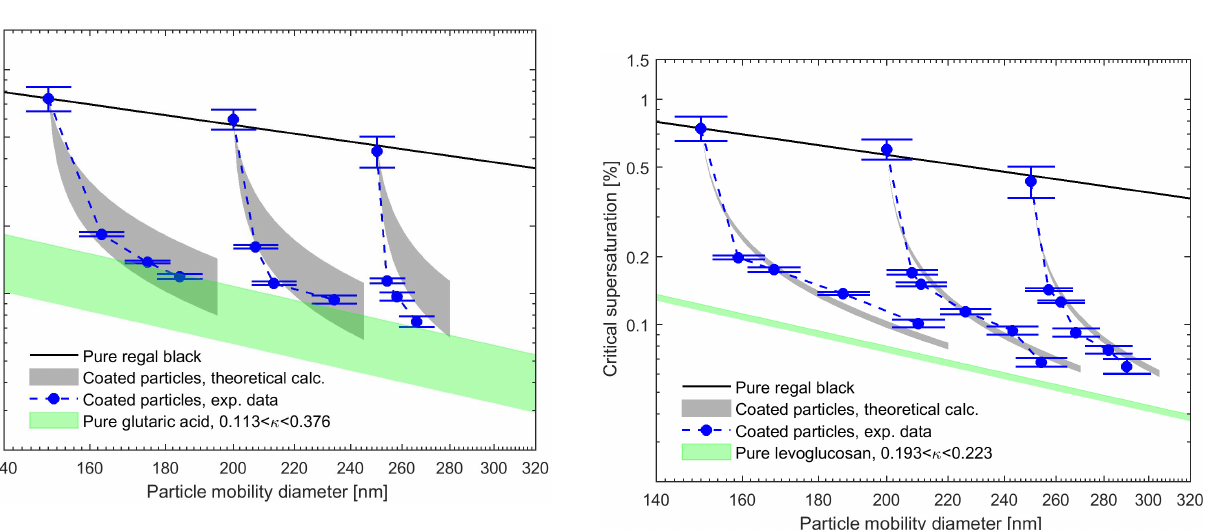
Figure 5. Experimental and theoretical critical supersaturations for BC particles coated by glutaric acid for different particle mobility diameters. The black line represents the calculated critical super- saturations of the pure BC particles using the FHH adsorption ac- tivation theory (Eq. 10). The gray shaded areas define the critical supersaturations calculated using Eq. (9) and variety of the κ val- ues reported in the literature for glutaric acid (see Table 1). The green shaded area represents the critical supersaturations from the κ -Köhler theory (Petters and Kreidenweis, 2007) for the pure glu- taric acid particles with the range of κ values from literature. Error bars represent the experimental uncertainty in the critical supersat- uration s c corresponding to each mobility diameter.